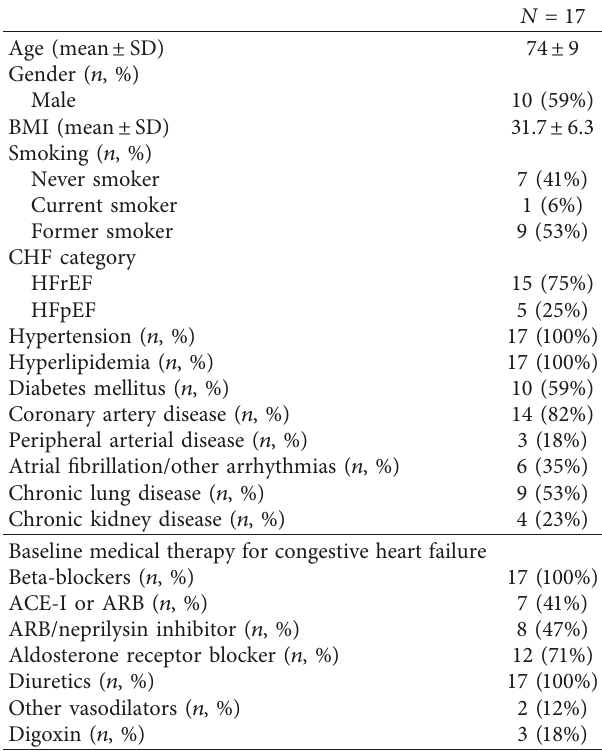
Table 1: Baseline